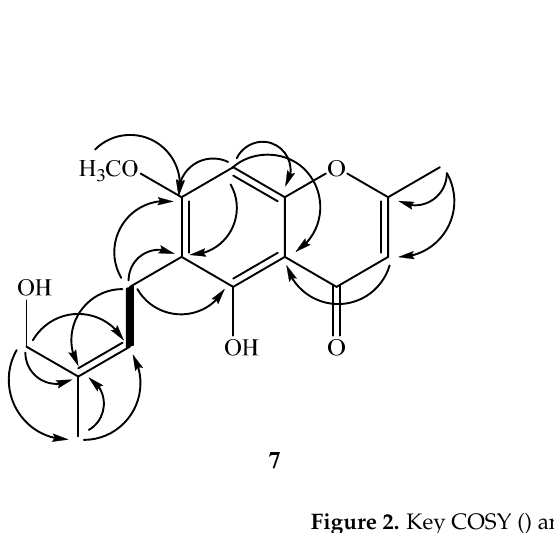
Figure 2. Key COSY ( ▬ ) and HMBC ( → ) correlations of 1 ‒ 8 .